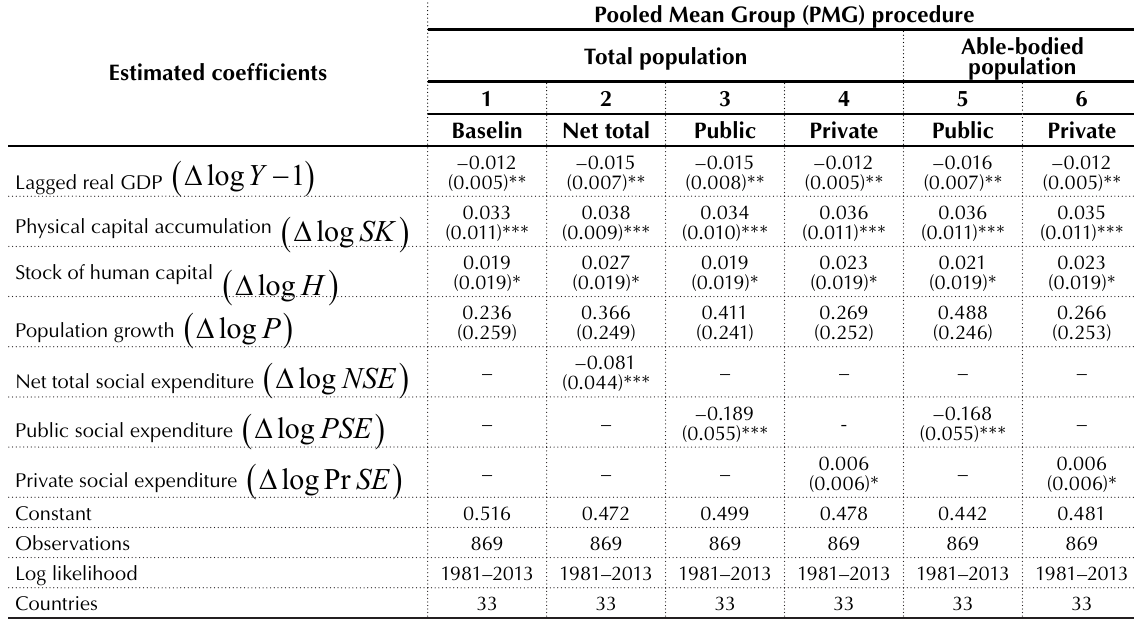
Table 7. Assessment of the social expenditure impact (public and private) on the economic